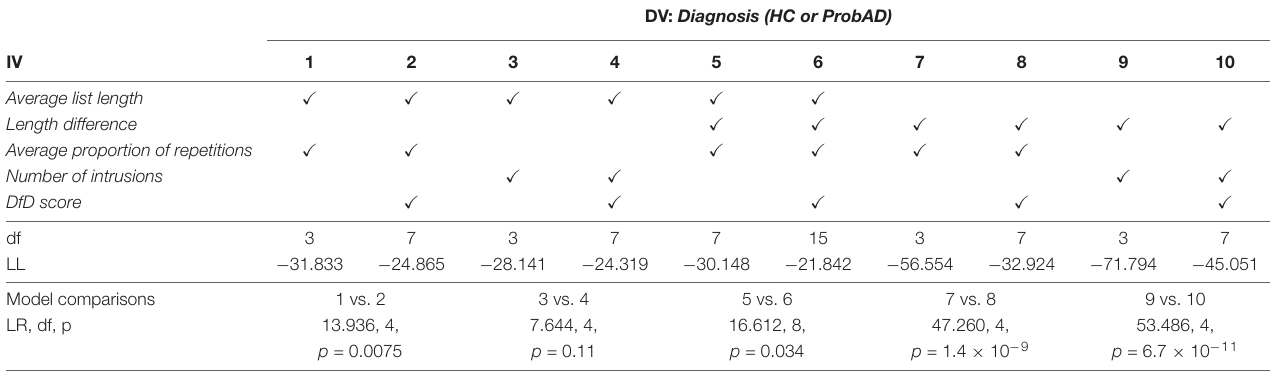
TABLE 2 | Regression results.